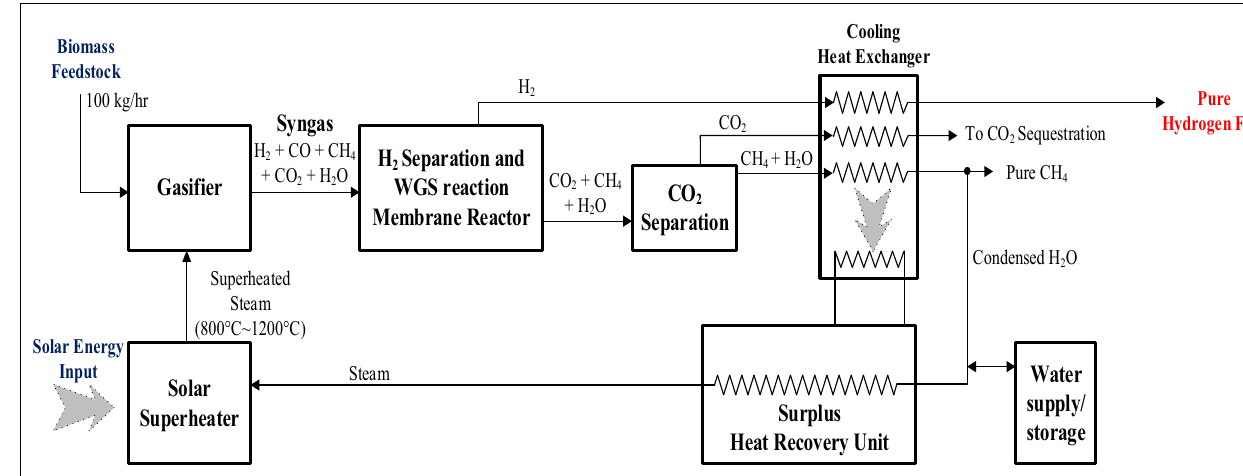
FIGURE 4 | Schematic of the integrated biomass to energy concept system II .